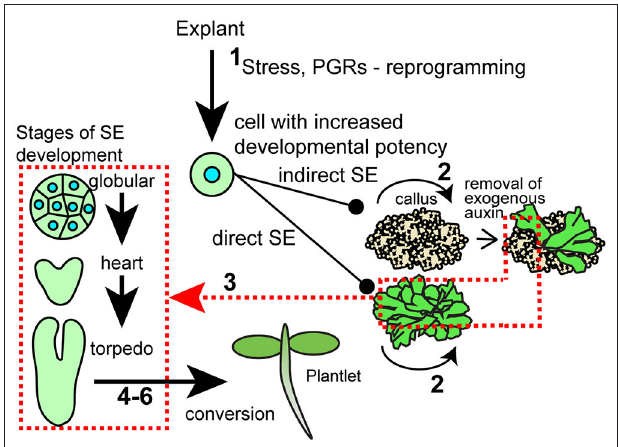
FIGURE 1 | Diagram of stages of SE. Please see the text for a description of what the numbers